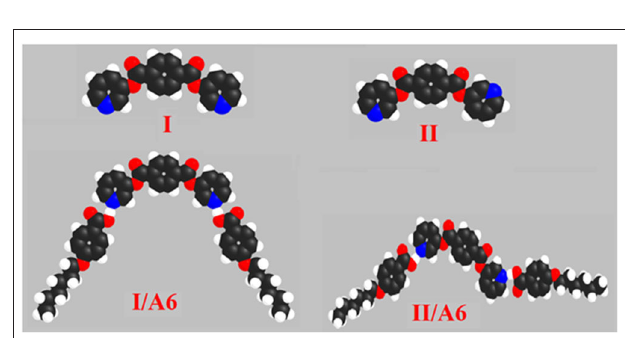
FIGURE 5 | Calculated molecular geometrical conformers of the base I , and their SMHBCs, I/A 6, and II/A 6